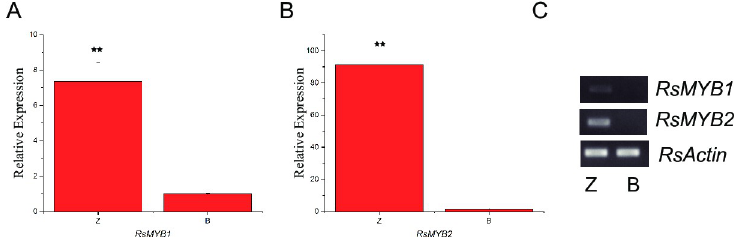
Fig 5. qRT-PCR and RT-PCR analysis of RsMYB1 and RsMYB2 between dark red and white radish taproots. Error bars indicate standard deviations for three biological replicates. �� reveals significantly different with P <